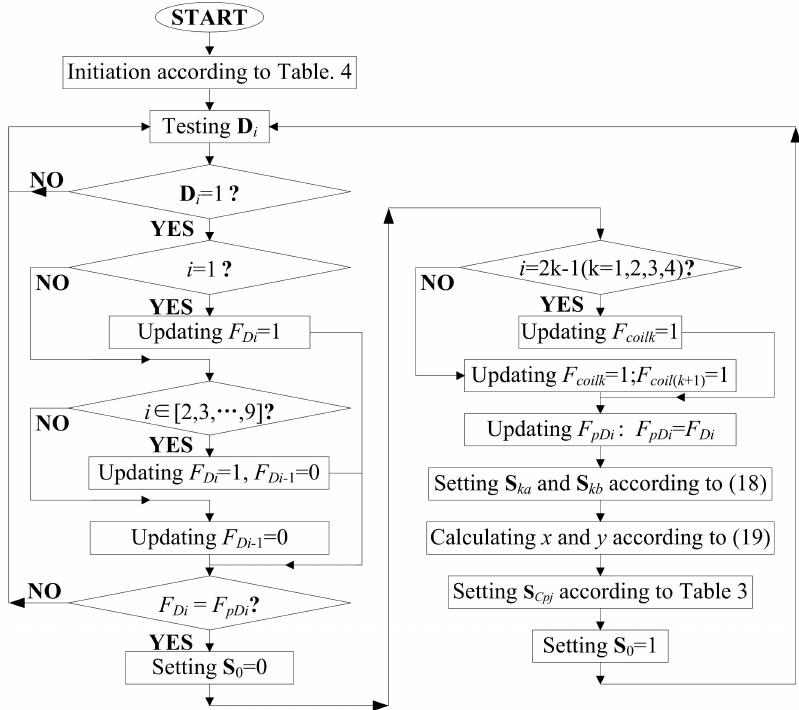
Figure 10. The flow of the proposed control strategy for switching control and power